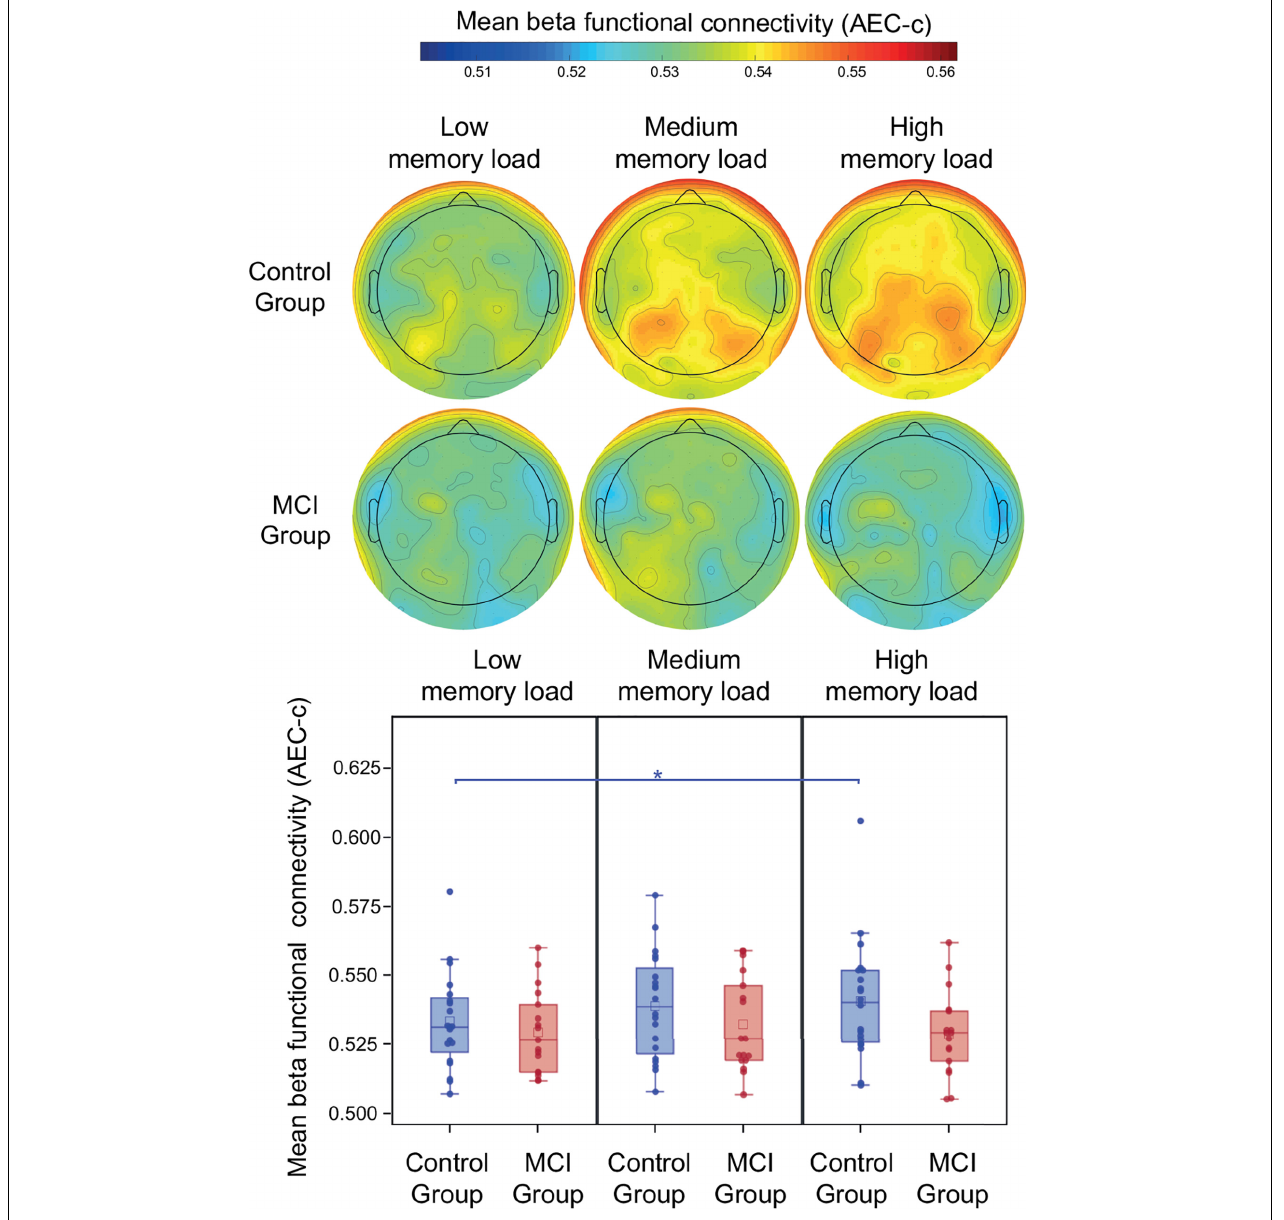
FIGURE 4 | Mean beta AEC-c in the retention condition of the PAL test. Functional connectivity in the beta frequency band (measured by AEC-c) during the retention period of the PAL test and topographical representation of the mean AEC-c values of EEG electrodes (i.e., the average functional connectivity strength to all other electrodes). * p <